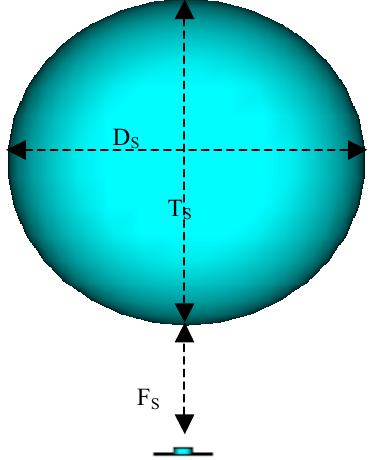
Figure 14: Geometry of a single DRA loaded with upper dielectric